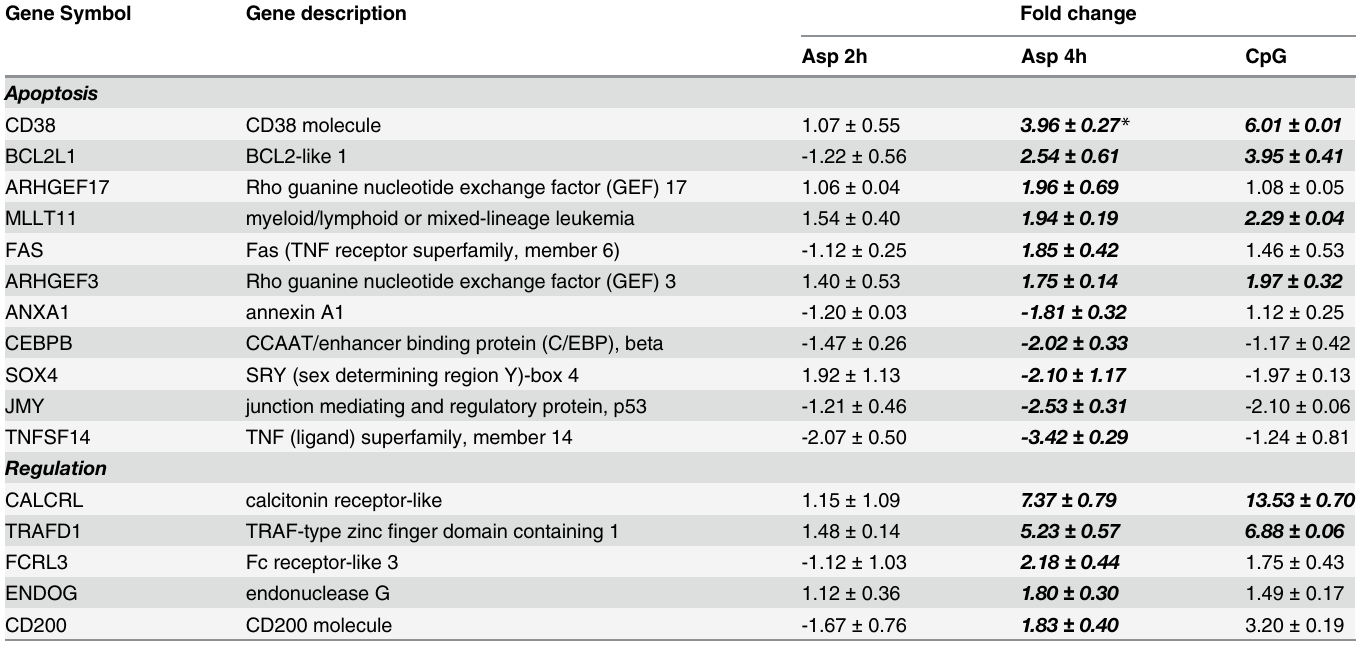
Table 4. Apoptosis and